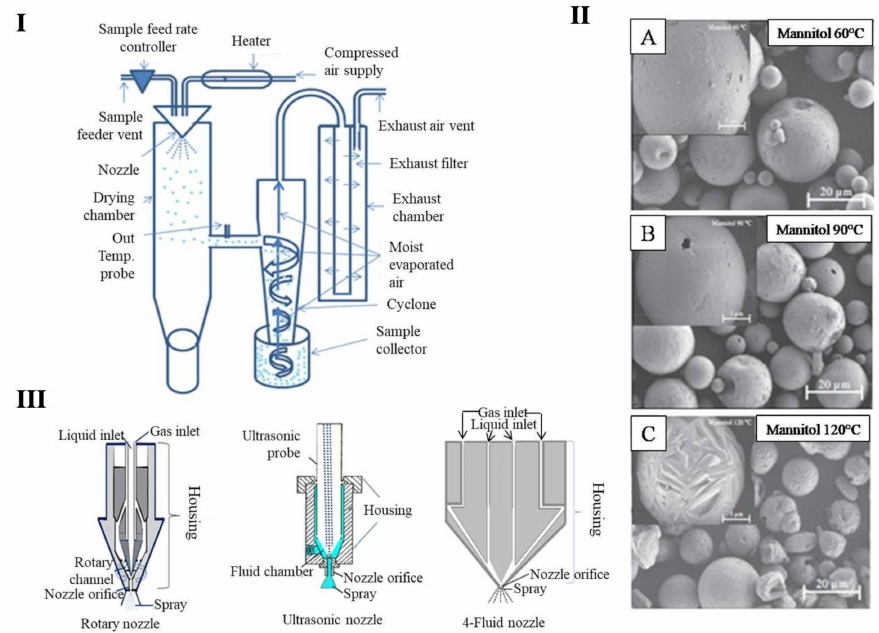
Figure 4. Spray drying technique. ( I ) Schematic diagram of spray dryer and its component; ( II ) scanning electron microscope image of spray-dried mannitol, ( A ) at 60 ◦ C, ( B ) at 90 ◦ C, and ( C ) at 120 ◦ C of outlet temperature. Reproduced with permission from [107], Elsevier, 2011; ( III ) schematic diagram of different